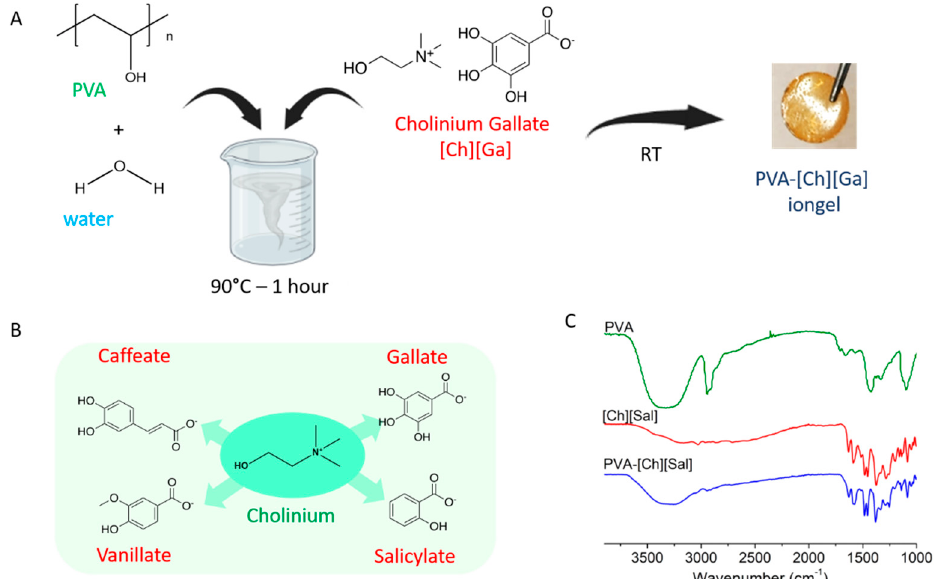
Figure 1. ( A ) Schematic representation of iongel formation by self-assembly of phenolic-based ILs and PVA and ( B ) chemical structures of the four phenolic-based ILs. ( C ) FTIR spectra for PVA, [Ch][Sal] IL, and PVA-[Ch][Sal] iongel.